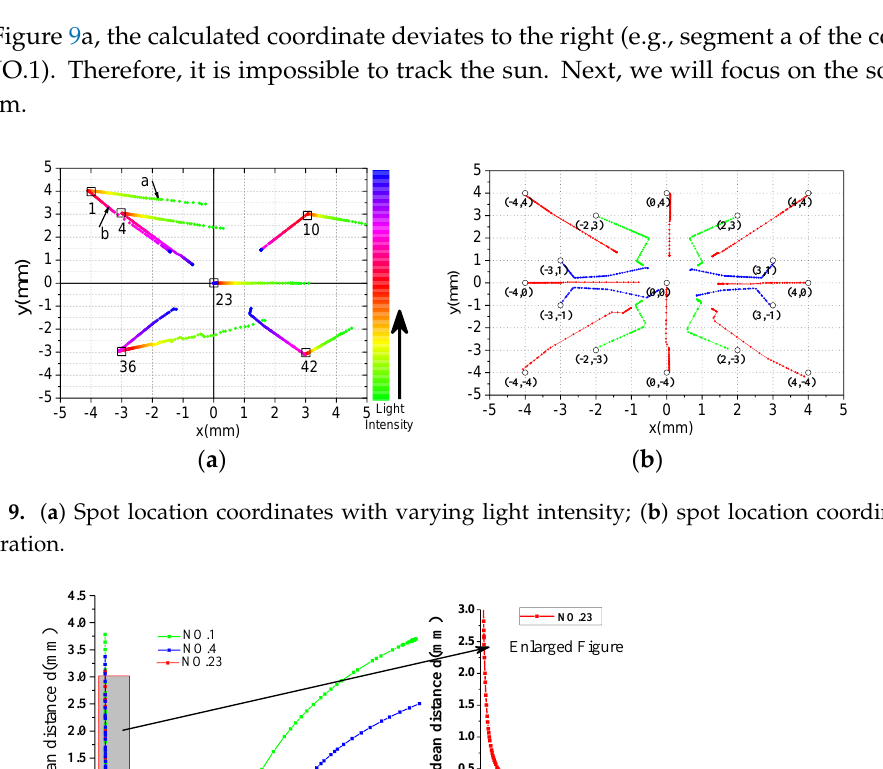
Figure 9. ( a ) Spot location coordinates with varying light intensity; ( b ) spot location coordinates at saturation.